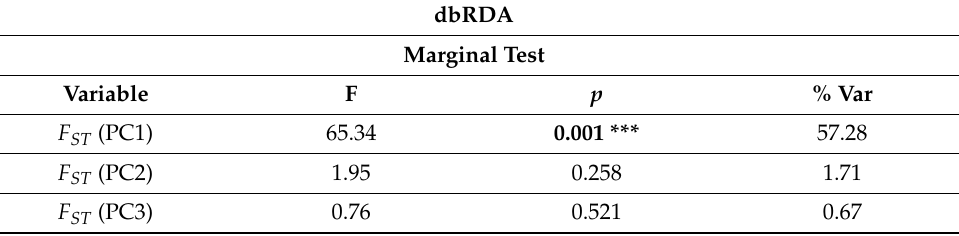
Table 3. Results of the distance-based redundancy analysis (dbRDA) of the four Valerianella sections obtained from the marginal test that tested the correlation between the genetic distances of the populations ( F ST ) (explanatory variable) and the morphological differentiation of the sections based on their diagnostic carpological traits (response variable, see Table 1). Significance of predictors test: p < 0.001